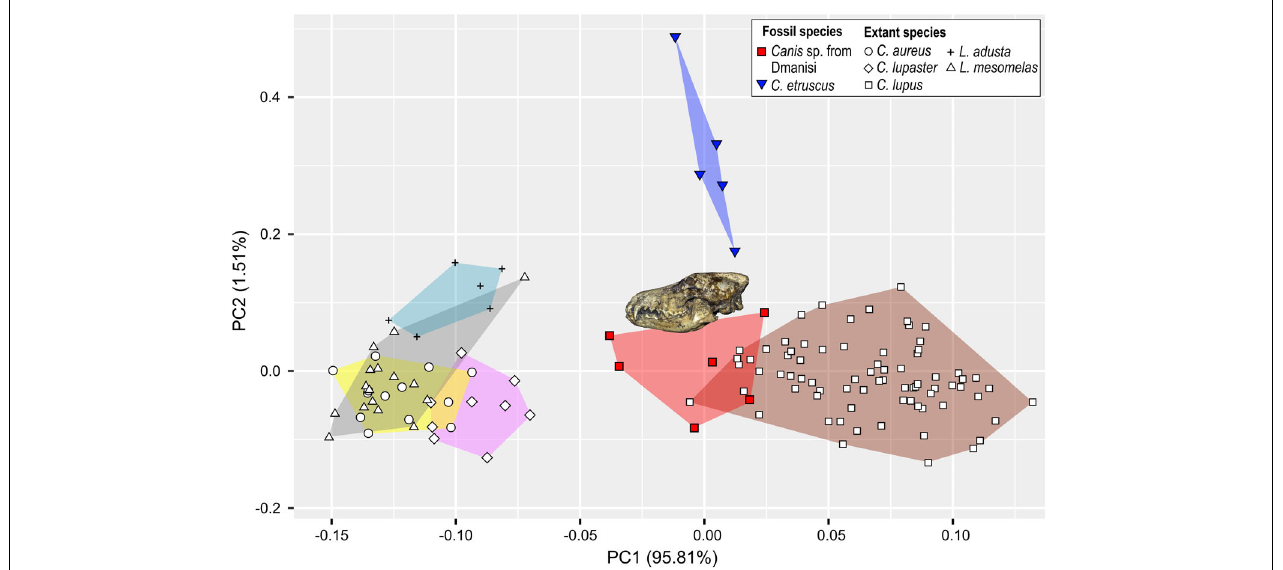
FIGURE 4 | Principal components analysis (PCA) based on selected log-transformed cranial measurements on extant and fossil species of the general Canis and Lupulella . Symbols are explained in the legend.